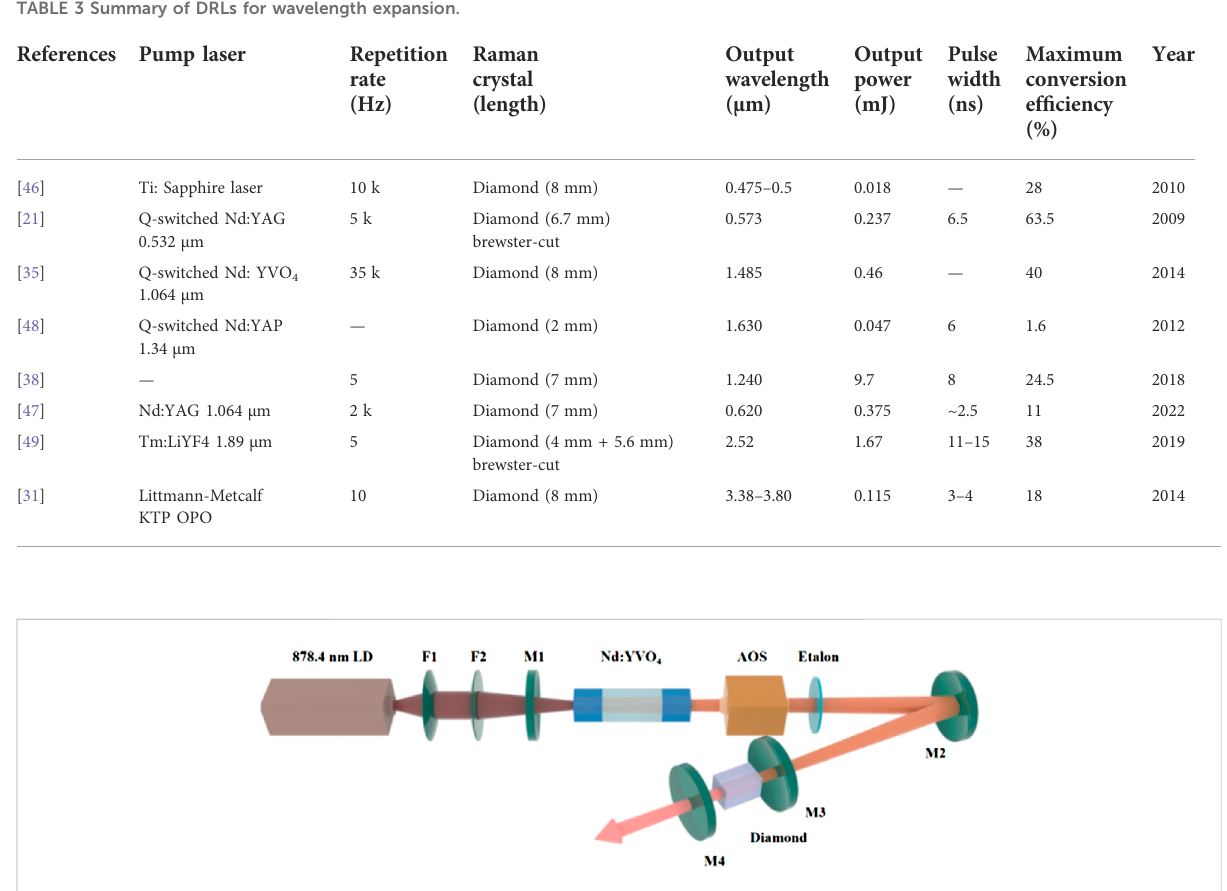
FIGURE 7 Diagram of the ns pulsed SLM DRL at 1.634 μ m reported in Ref. [26]. LD, laser diode; F1 + F2, telescopic system; M, mirror; AOS, acousto-optic switch. Image originally published in Ref. [26] and reproduced with permission from Optica Publishing group © The Optical